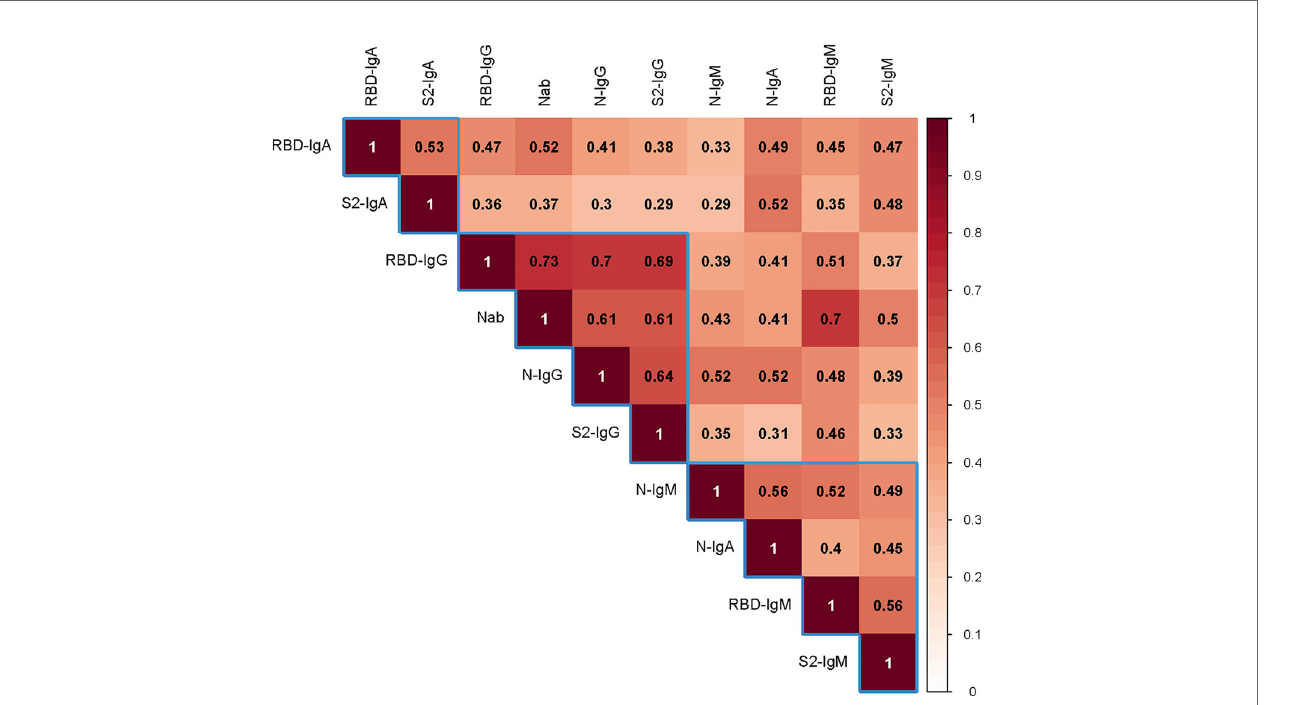
FIGURE 3 | The correlation between the Nab titers and various antibodies. Spearman ’ s correlation test was used to examine the correlation between the Nab titer with various antibodies. Darker color indicates a stronger correlation. The number in the square is the relation value. The blue frame shows the clustering relationship. Ig, immunoglobulin; N, nucleocapsid protein; Nab, neutralizing antibodies; RBD, receptor-binding domain; S,